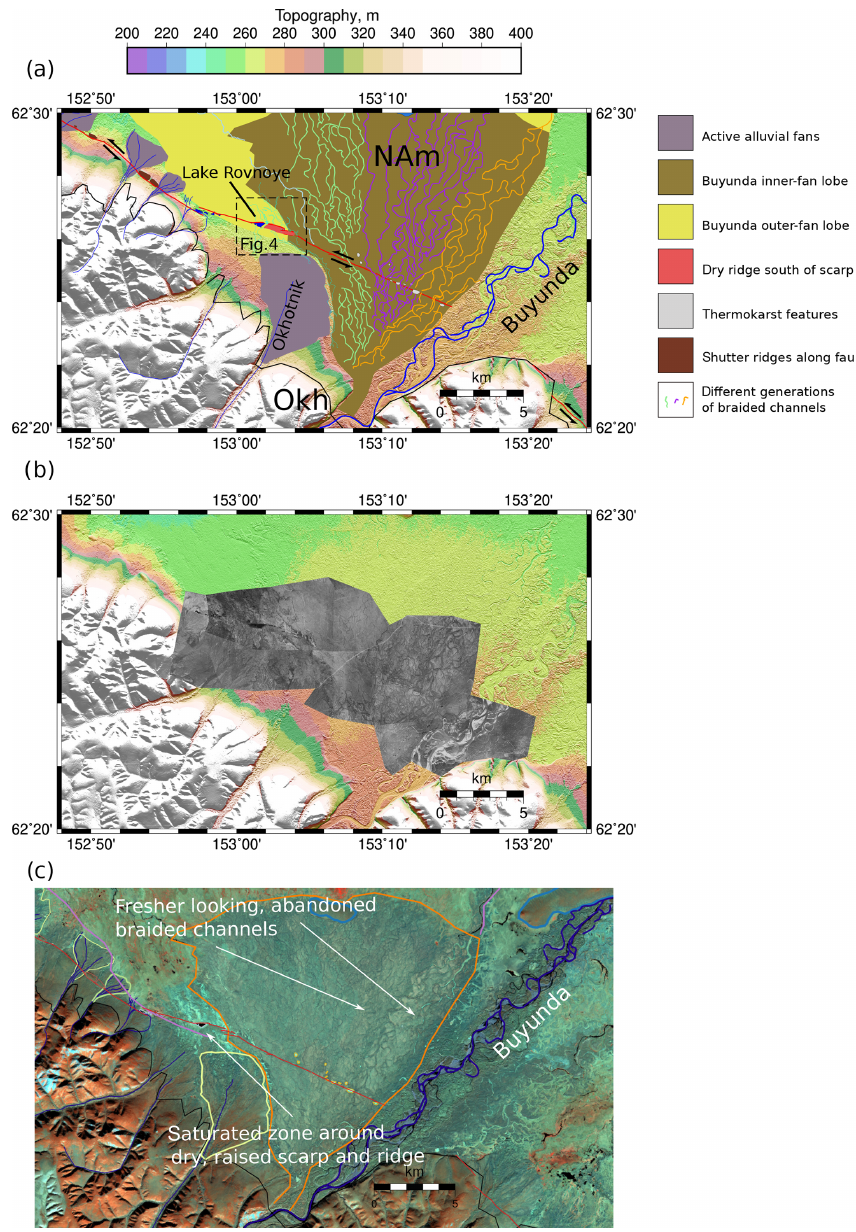
Figure 3. Study area. (a) Detail of the Buyunda fan and the fault trace across it, showing lakes, scarp and ridge, thermokarst, shutter ridges, and subsidiary alluvial fans. (b) Detail of georeferenced aerial photo mosaic used for interpretation. Red dots show sample site locations. (c) Landsat false colour image (567 infrared bands) of same area. Saturated zone at the toe of Okhotnik fan shows up as lighter colours. Scarp and ridge is noticeably “drier” in this region. Older fan-top channels (previous course of Buyunda) appear “fresher” or more clearly defined and sharper the further east they are, suggesting fan surface may be progressively younger in this